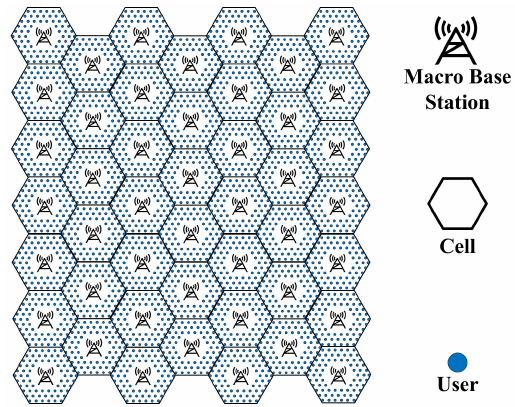
Figure 1. Schematic of a 5G macro BS network.